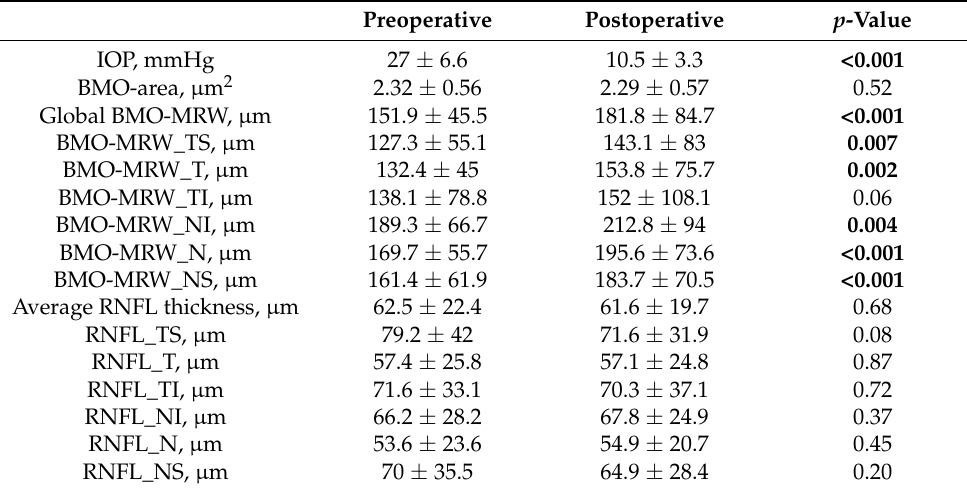
Table 2. Intraocular pressure, BMO-MRW, and RNFL thickness at baseline and the postoperative OCT examination.